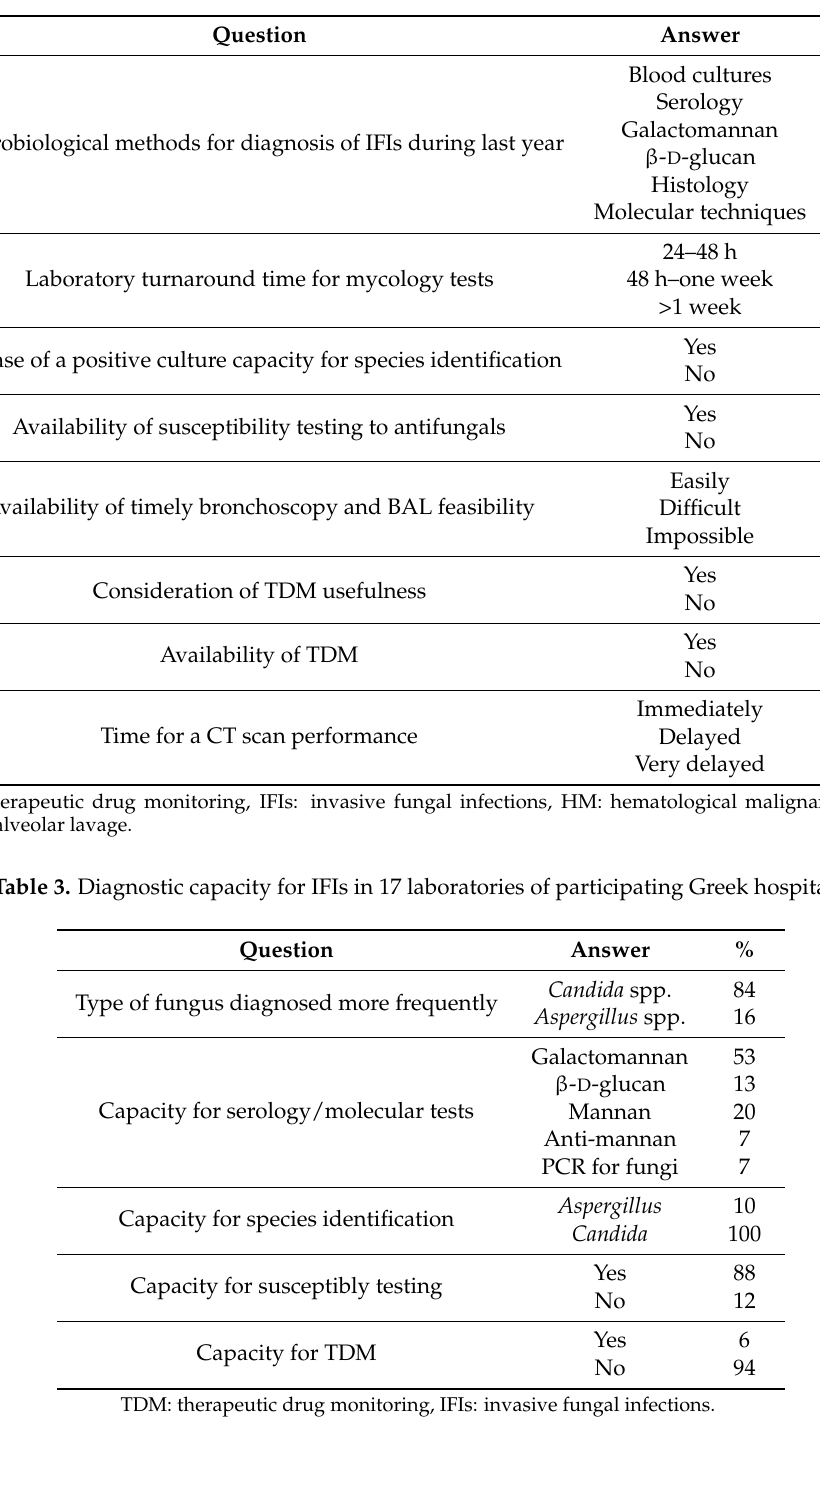
Table 2. Clinicians’ take on the diagnostics of IFIs in patients with hematological malignancies (HM). Question Answer % Microbiological methods for diagnosis of IFIs during last year Laboratory turnaround time for mycology tests In case of a positive culture capacity for species identification